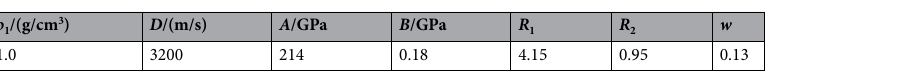
Table 2. Basic charge parameters and the JWL state equation parameters. ρ 1 is the charge density and D is the detonation wave speed.